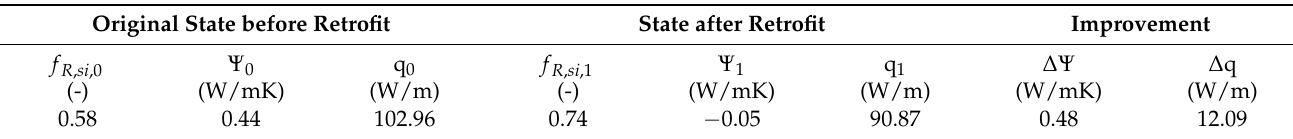
Table A13. Quantifiable results of the thermal bridge retrofit of a balcony slab (ThermCad thermal bridge simulation calculation).